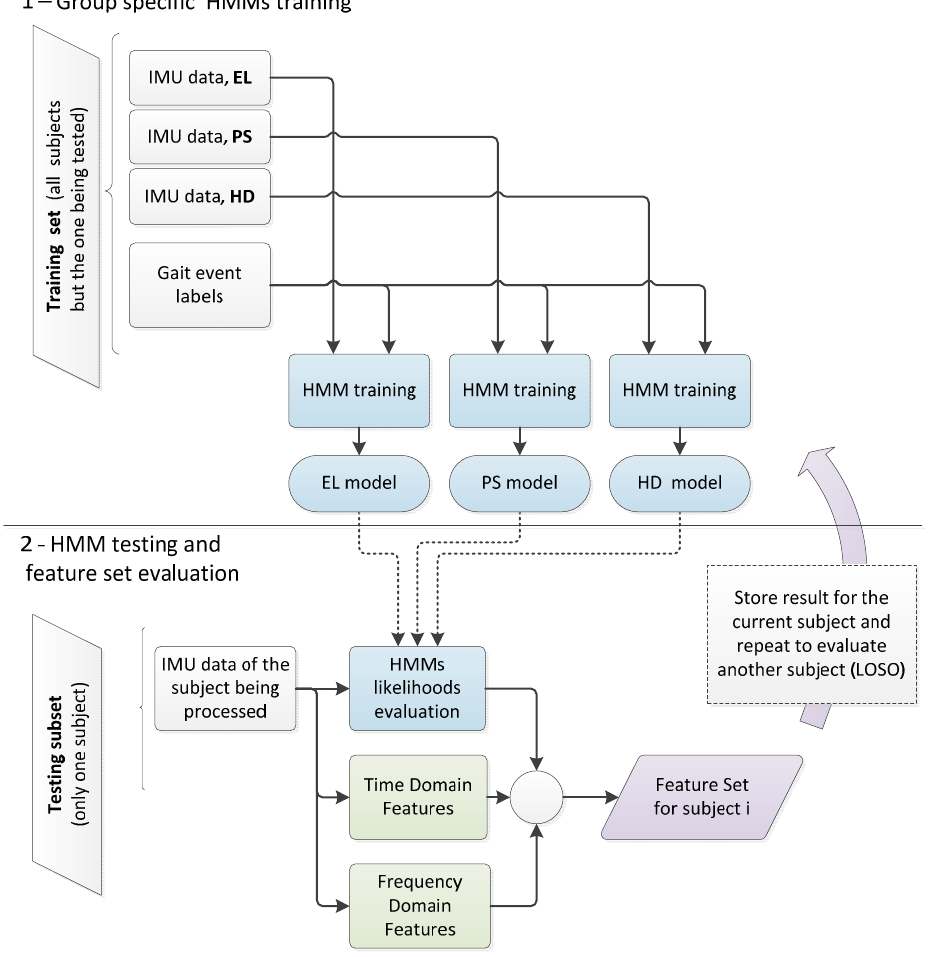
Figure 2. Feature set definition for classification. The information from the subject being tested was not included in the training set.